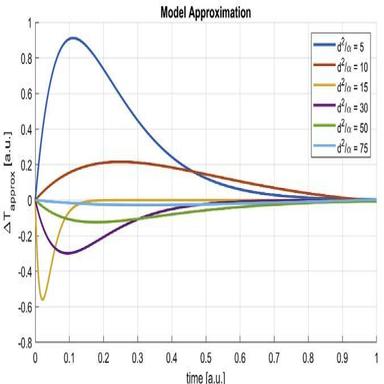
Results of the application of the model in Eq. on the profiles in